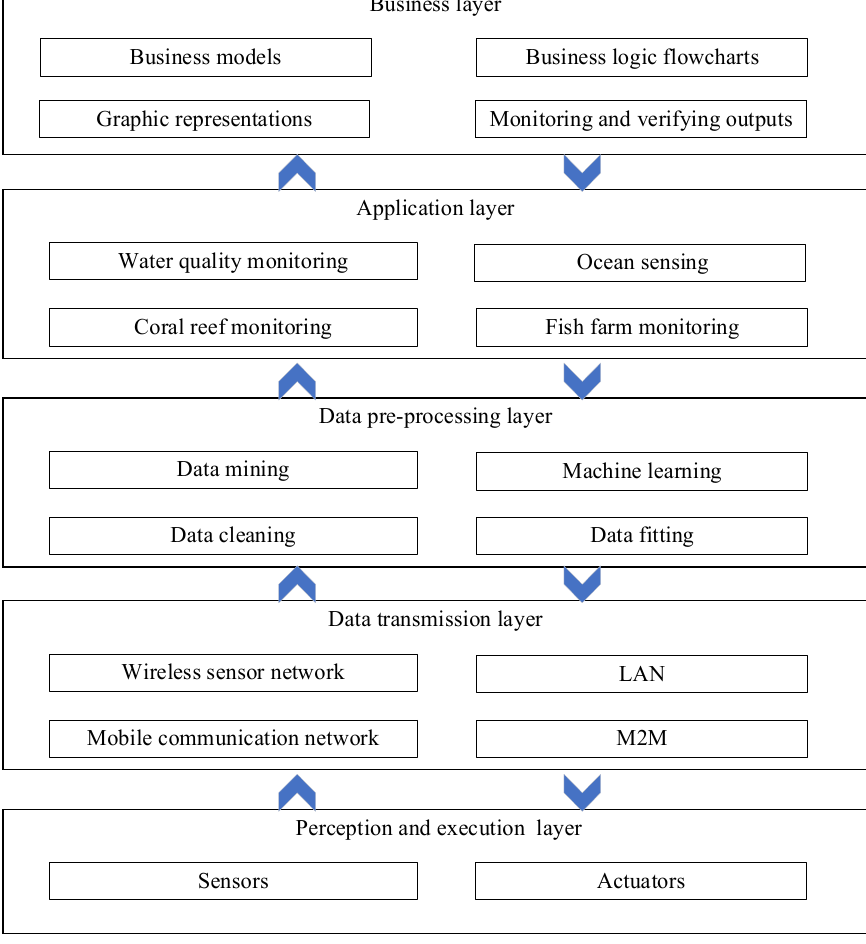
Figure 1. Common layered architecture for Internet of Things (IoT)-based marine environment monitoring and protection applications.